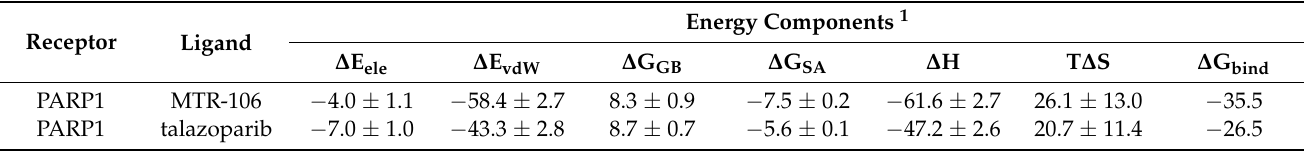
Table 4. Binding-free energies between PARP1 and the binding ligands.